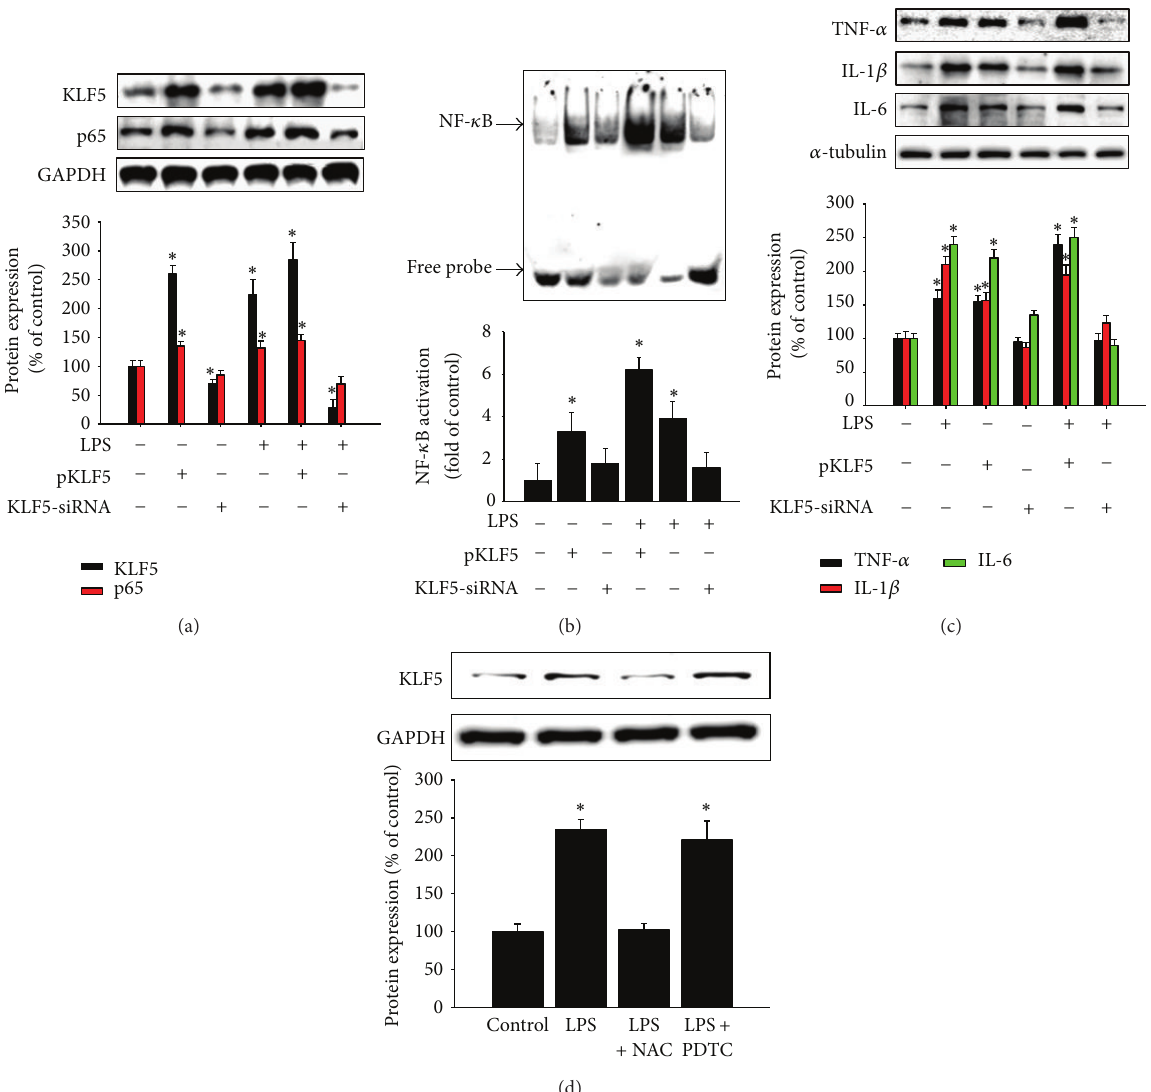
Figure 4: Effects ofKr¨uppel-like factor 5 (KLF5) overexpression or silencing on p65 phosphorylation and nuclear factor-kappaB (NF- 𝜅 B) activity. (a) Cells from the HBEC line were pretreated with the pKLF5 plasmid or transfected with KLF5 small interfering RNA (siRNA) for 48 h, and KLF5, p65, phospho-p65 (Ser276), and phospho-p65 (Ser536) protein expression were measured using western blotting. (b) NF- 𝜅 B activity was measured using an electrophoretic mobility shift assay, and (c) the proinflammatory cytokines tumor necrosis factor- 𝛼 (TNF- 𝛼 ), interleukin- (IL-) 1 𝛽 , and IL-6 were evaluated using western blotting. (d) Cells from the HBEC line were pretreated with N-acetylcysteine (NAC; 10 mM) or pyrrolidine dithiocarbamate (PDTC; 100 𝜇 M) for 1h and then treated with lipopolysaccharide (LPS; 5 𝜇 g/mL) for 1h. KLF5 protein expression was evaluated using western blotting. Silencing of KLF5 messenger RNA (mRNA) expression reduced LPS-induced p65 accumulation in the nucleus. (a) Compared with that in the control group, cells treated with LPS alone, or cells transfected with KLF5-specific smallinterferingRNA(siRNA),NF- 𝜅 BbindingactivityincellstransfectedwiththeKLF5plasmidincreasedinresponsetoLPS.(b)Compared with those in the control group, cells treated with LPS alone, or cells transfected with KLF5-specific siRNA, levels of the proinflammatory cytokines TNF- 𝛼 , IL-1 𝛽 , and IL-6 in cells transfected with the KLF5 plasmid were increased. (c) Cells pretreated with the NF- 𝜅 B inhibitor PDTC (100 𝜇 M) for 1h exhibited no reduction in KLF5 protein expression after LPS exposure. (d) Data are presented as means ± SEM from 3 independent experiments. Each bar graph shows summarized data (mean ± SEM) from 3 separate densitometry experiments after normalization to glyceraldehyde-3-phosphate dehydrogenase (GAPDH; an internal control for nuclear protein). ∗ 𝑃 < 0.05 versus medium alone or control